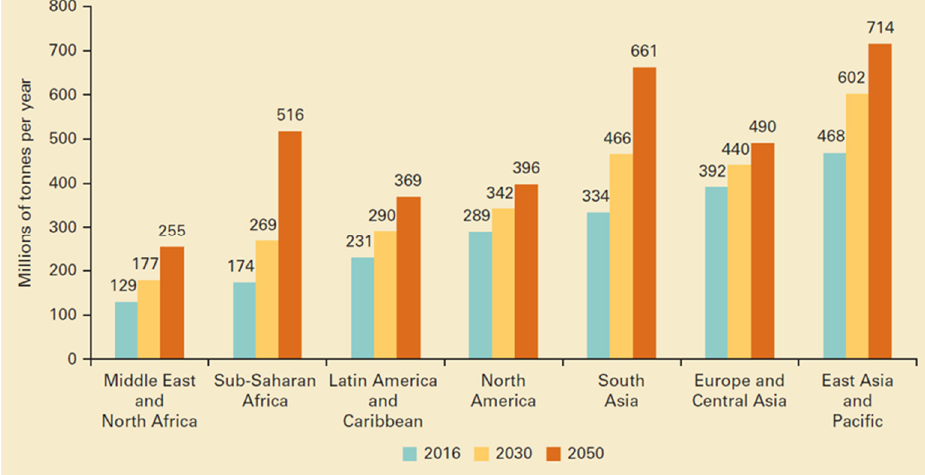
Figure 1. Projected waste generation by region (millions of tons/year) [5] .